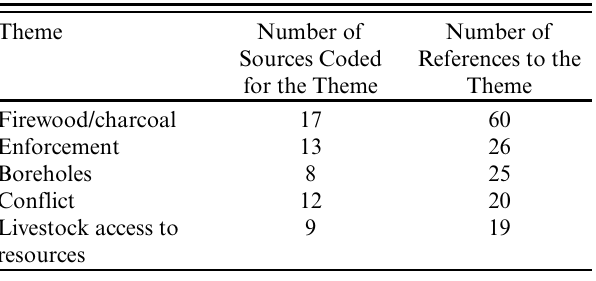
Table 4 . Emergent themes identified in interviews and focus group